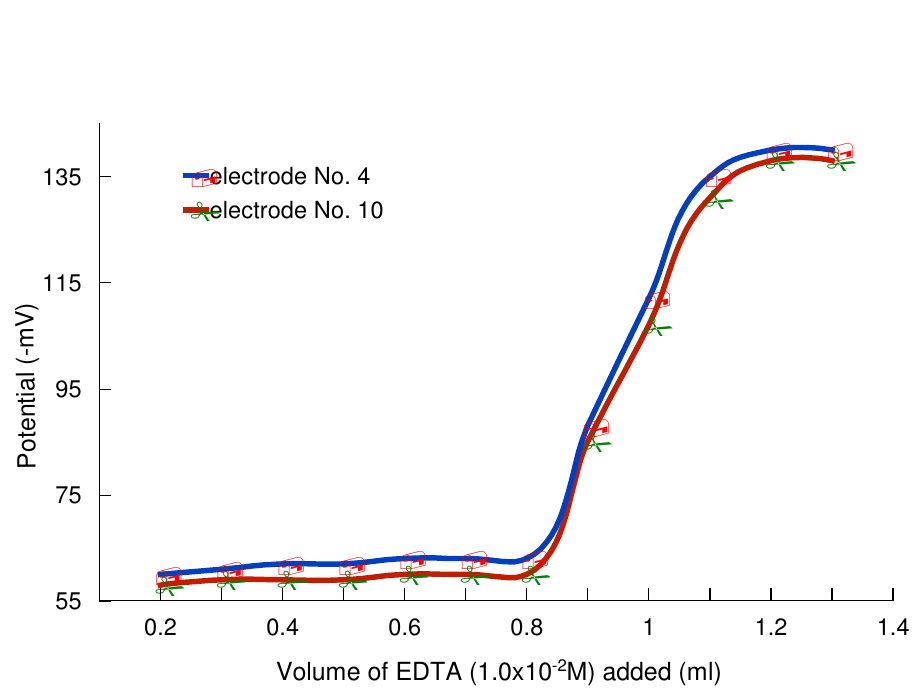
Figure 6 : Potentiometric titration plot of Ni 2+ ions (1.0x10 -3 M) with EDTA (1.0x10 -2 M), electrode no. 4 and electrode no.